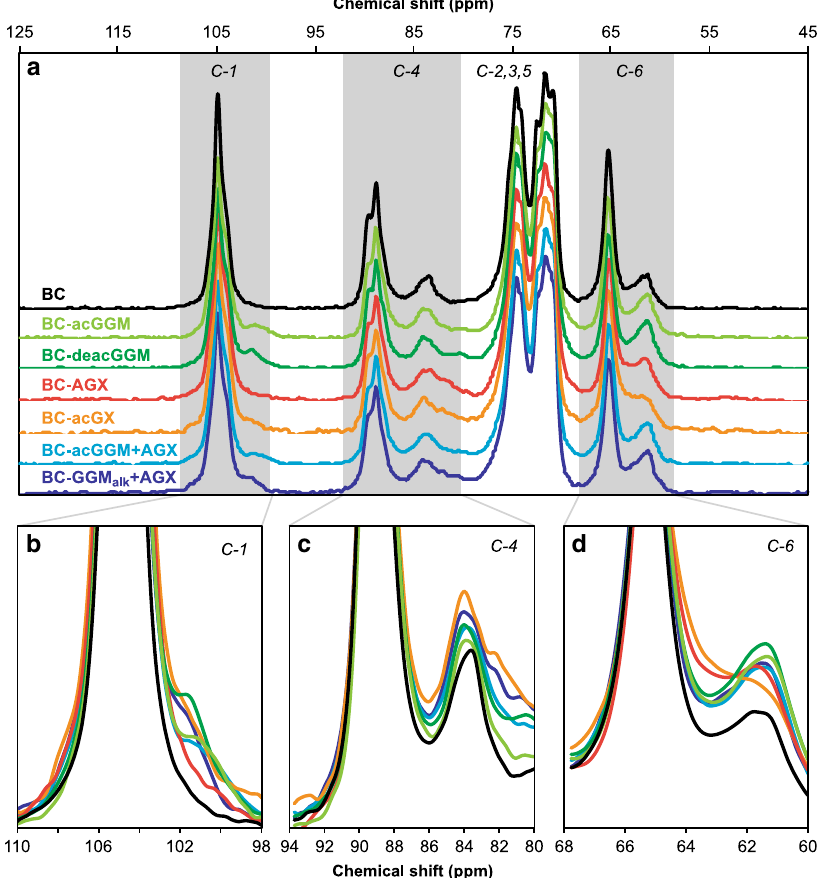
Fig. 4 Interactions in BC-H hydrogels by solid-state 13 C CP/MAS NMR analysis. a Full spectra of the hydrated BC-H samples. b – d Magni fi cation of the C- 1 and C-4 regions of the NMR spectra for the spruce wood analogs, including BC-acGGM, BC-deacGGM (the same pellicle after a pH 10 wash for acetyl group removal), BC-GGM alk + AGX, and BC-acGGM + AGX. Source data are provided as a Source Data fi